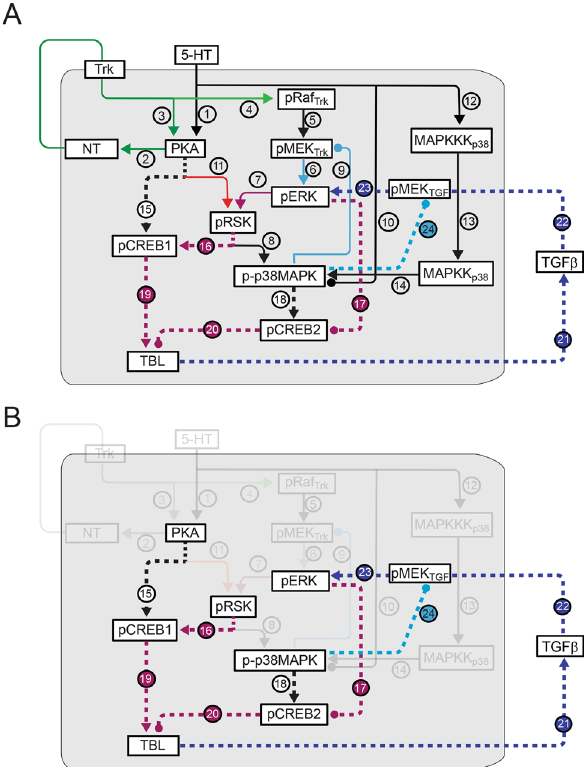
Figure 4. Schematic network including transcription factors CREB1/2, regulated by PKA and MAPK signaling pathways. ( A ) Complete pathways in the extended model. The pathways from Fig. 3A are represented as solid, thinner, lines, and the pathway numbers are indicated with unfilled circles. The newly added pathways are dashed, thicker lines, and pathway numbers are indicated with filled circles. The PKA and MAPK cascades interact to regulate the phosphorylation and activities of CREB1 and CREB2, which regulate the expression of TBL. TBL subsequently activates TGF-β. Violet denotes two ERK – > TBL pathways: ERK- > RSK- > CREB1- > TBL, pathway 7- > 16- > 19); ERK- > CREB2- > TBL, pathway 17- > 20). Arrowheads indicate activation, circular ends indicate repression. ( B ) Network highlighting the addition of new pathways, with the previous pathways made